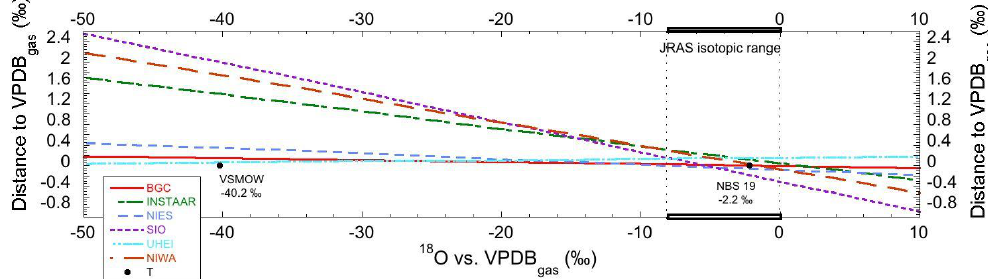
Figure 5. Extrapolation based on linear regression of the JRAS δ 18 O data Fig. 5. Extrapolation based on linear regression of the JRAS δ 18 O